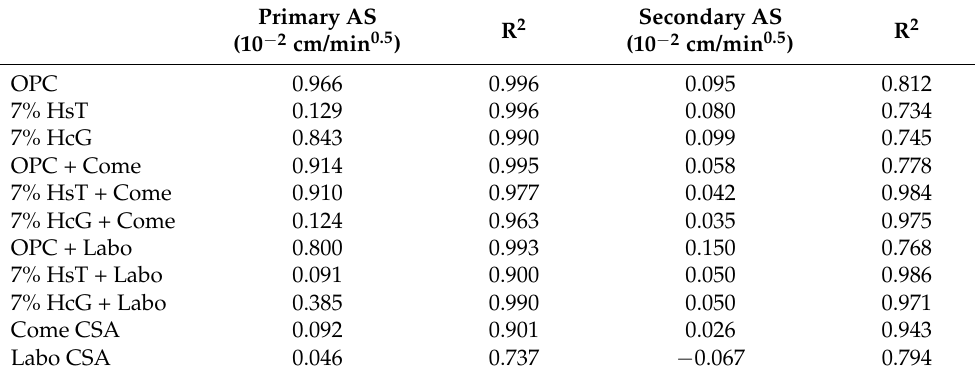
Table 6. Coefficient values corresponding to primary and secondary absorption sorptivity (AS). Primary AS (10 − 2 cm/min 0.5 ) (10 − 2 cm/min 0.5